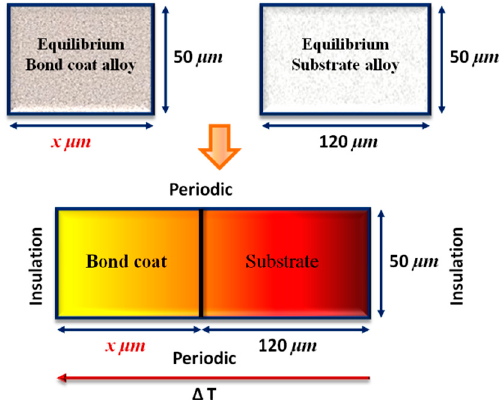
Figure 2. Schematic diagram for the procedure, geometry and boundary conditions for the present phase-field